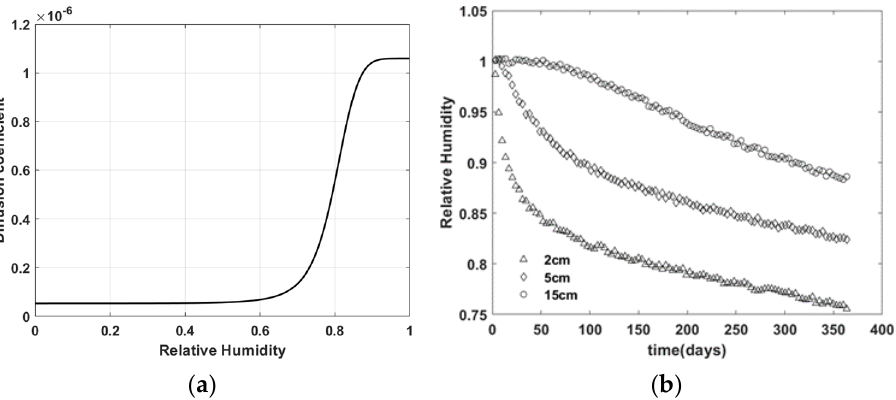
Figure 3. Virtual experiment data with material M1—( a ) moisture diffusion model D; ( b ) relative humidity distribution over time.